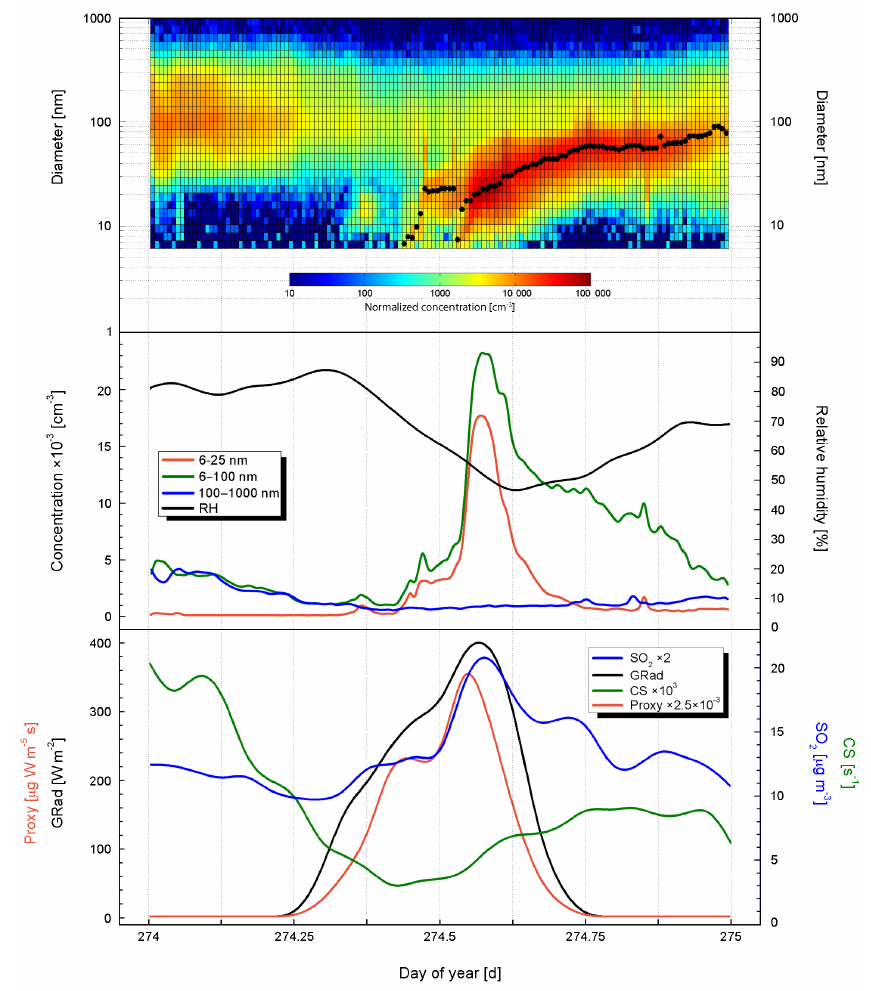
Figure 5. Surface plot (upper panel) for Sunday, 30 September 2012, showing an NPF and growth event with double consecutive start in the near-city background of Budapest. Time series of the fitted particle number median diameter for the nucleation mode are indicated by black dots. For the onsets 1 and 2, the J 6 s were 1.34 and 5.9cm − 3 s − 1 , respectively, the GRs were 7.7 and 12.9nmh − 1 , respectively, and the start- ing times t 1 were 09:53 and 12:18 current local time (UTC + 2), respectively. Temporal evolution of particle number concentrations N 6 − 25 , N 6 − 100 and N 100 − 1000 and of RH are displayed in the middle panel. The lower panel shows the diurnal variation of SO 2 concentration, GRad, CS and gas-phase H 2 SO 4